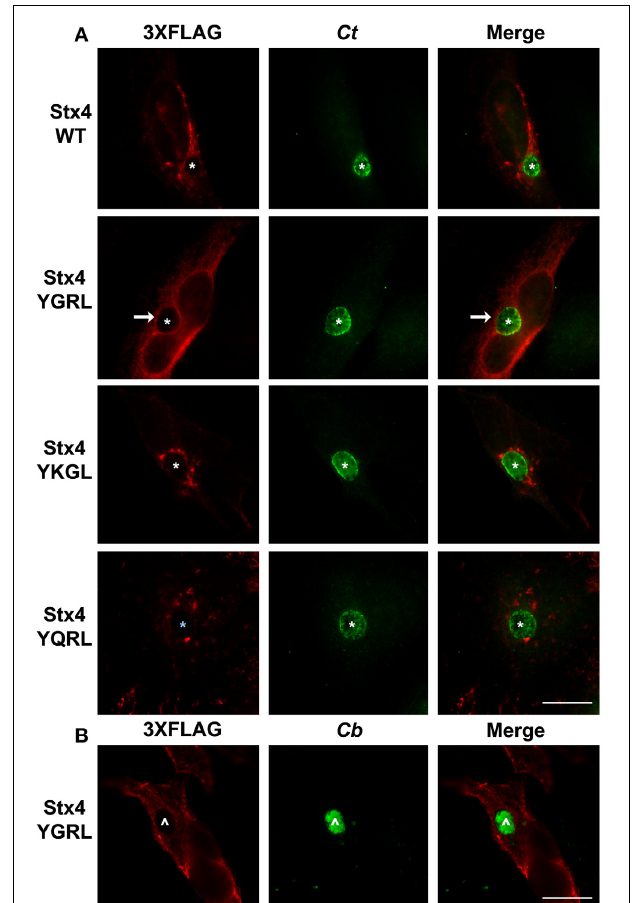
FIGURE 3 | Examination of syntaxin 4 YXXL mutant colocalization with the chlamydial inclusion. HeLa cells were transfected with 3XFLAG-syntaxin 4 (Stx4) or one of three 3xFLAG-syntaxin 4 signal sequence insertion mutants and infected with C. trachomatis serovar L2 ( Ct ) (A) or C. burnetii ( Cb ) (B) . Cells were fixed in ethanol and processed for indirect immunofluorescence assay to detect 3XFLAG (red), C. trachomatis [green, (A) ] or C. burnetii [green, (B) ]. Each image is representative of at least two independent experiments. White stars designate the chlamydial inclusion, white caret designates the C. burnetii vacuole and white arrows denote colocalization of syntaxin 4-YGRL with the chlamydial inclusion. Bars, 10 μ